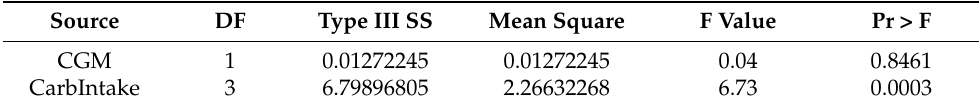
Table A7. A1C < 7% with CGM and CarbIntake as independent variables.